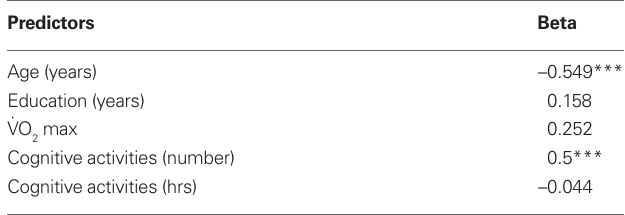
Table 4 | Summary of final significant model for prediction of global cognitive score when V˙O max is included. 2